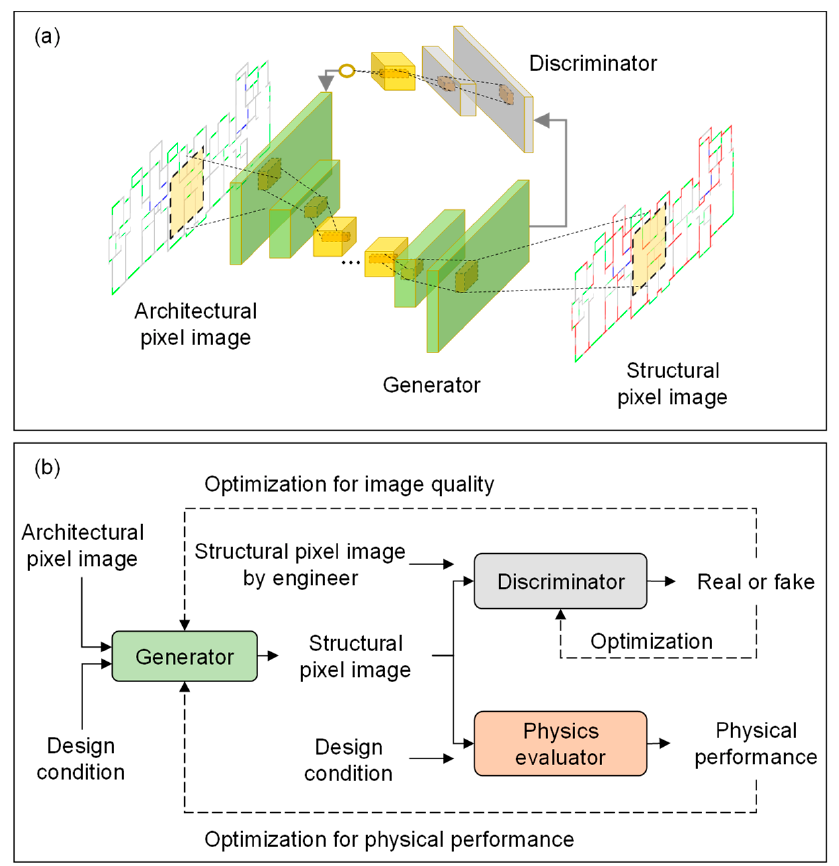
Figure 4. Intelligent structural design based on GAN: ( a ) data-driven GAN (StructGAN); ( b ) physics-enhanced GAN (StructGAN-PHY).